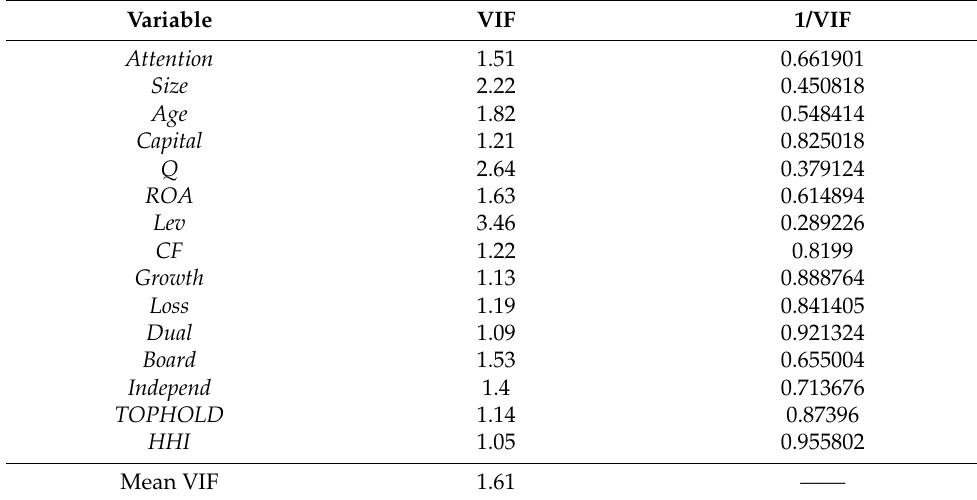
Table A2. Variance inflation factor (VIF)